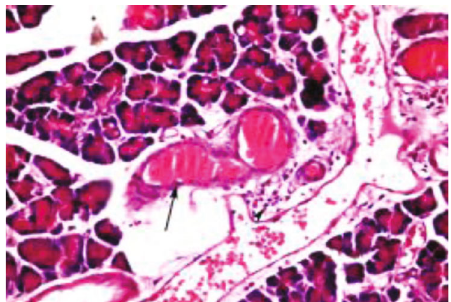
Figure 7: Photomicrograph of pancreatic tissue of F. carica (200mg/ kg BW)-treated animal showing inspissated pancreatic duct (arrow) and perivascular in fl ammatory in fi ltration (arrowhead) (H&E) ( × 400).